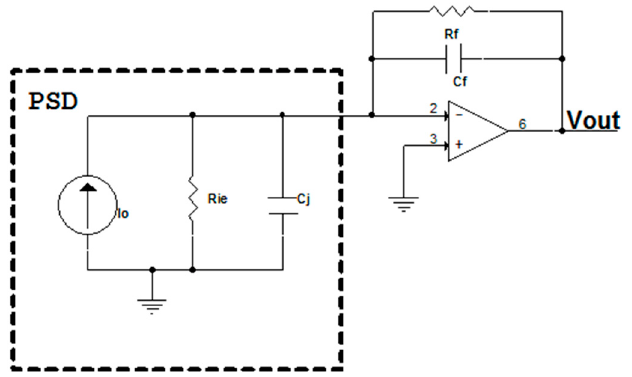
Figure 15. Amplifier I/V converter circuit.